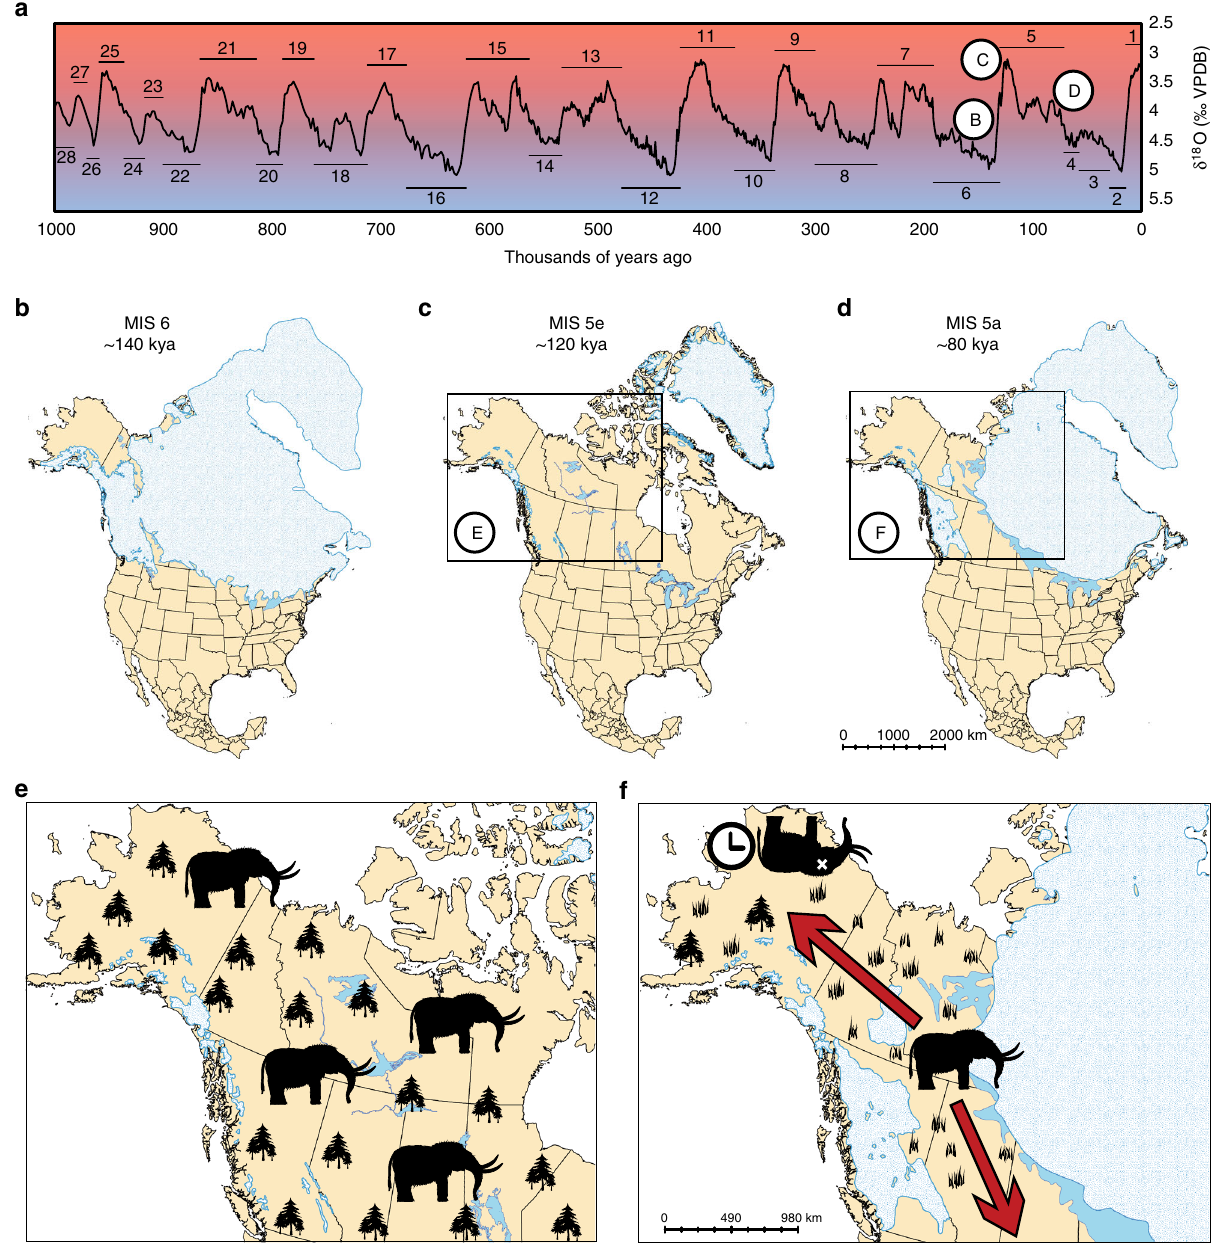
Fig. 2 Model of mastodon extirpation and expansion in response to glacial cycles. a Global stack of benthic foraminifera δ 18 O for the last 1 million years, which tracks changes in deep-water temperature and global ice volume. The y -axis has been inverted so that periods of low ice buildup (and higher temperatures — red) are at the top of the graph, and periods of greater ice buildup (and lower temperatures — blue) are at the bottom. Marine Isotope Stage (MIS) extents are indicated with black bars above (interglacials) or below (glacials) the δ 18 O record. δ 18 O values and MIS terminations can be found in Lisiecki and Raymo 7 . One full glacial cycle is represented, showing the change from glacial ( b ) to interglacial ( c ) conditions, followed by a fall back into another glaciation ( d ). North American ice-sheet cover at each stage ( c , d ) is approximated from recorded δ 18 O to similar conditions during the transition out of the last glaciation 8 , or from published simulations where available ( b ) 65 . The ecological implications of these transitions are summarised in ( e , f ), with mastodons being able to occupy most of eastern Beringia and Canada during interglacials ( e ), but progressively extirpated from these regions as conditions descend into the next glacial period ( f ). Populations would either need to retract to unglaciated regions south of the ice sheets or north to temporarily unglaciated refugia which would be unlikely to support mastodon populations throughout long